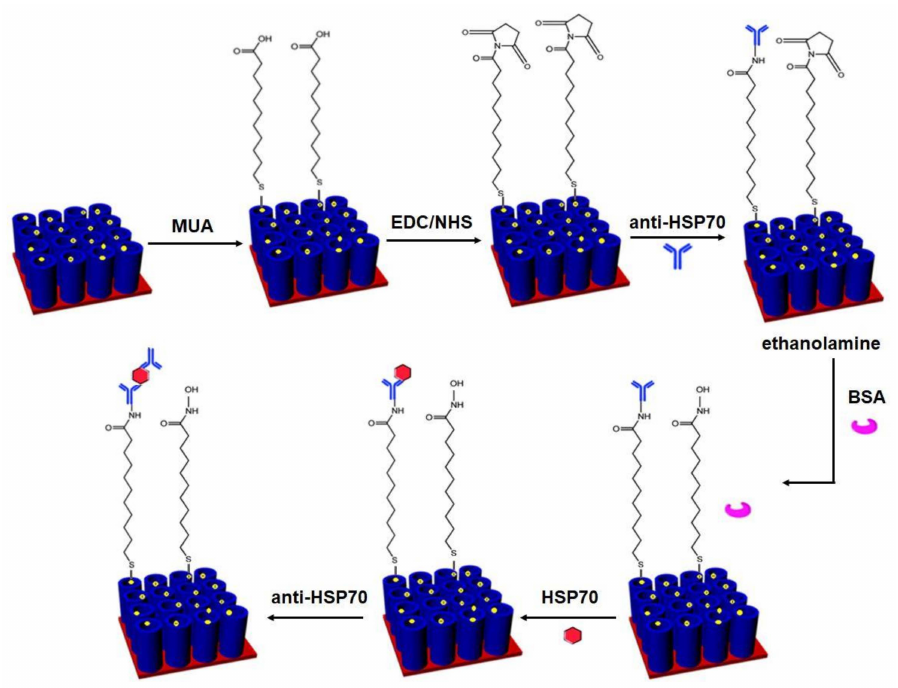
Figure 1. Schematic procedure of covalent functionalization of the AgNPs/TNTs biosensor for the determination of